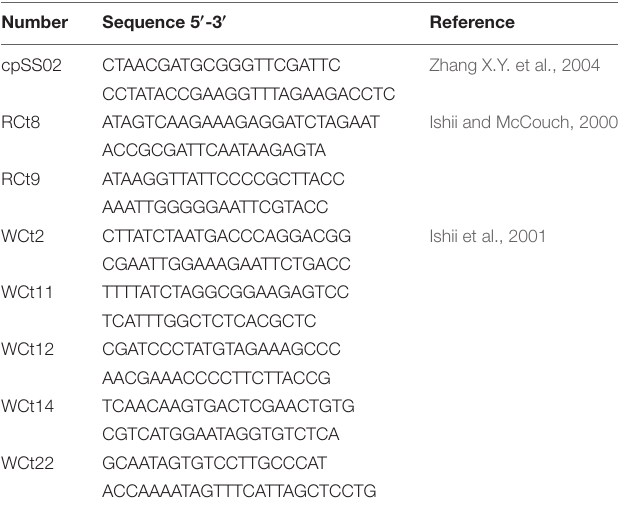
TABLE 1 | Primer sequences for cpSSR